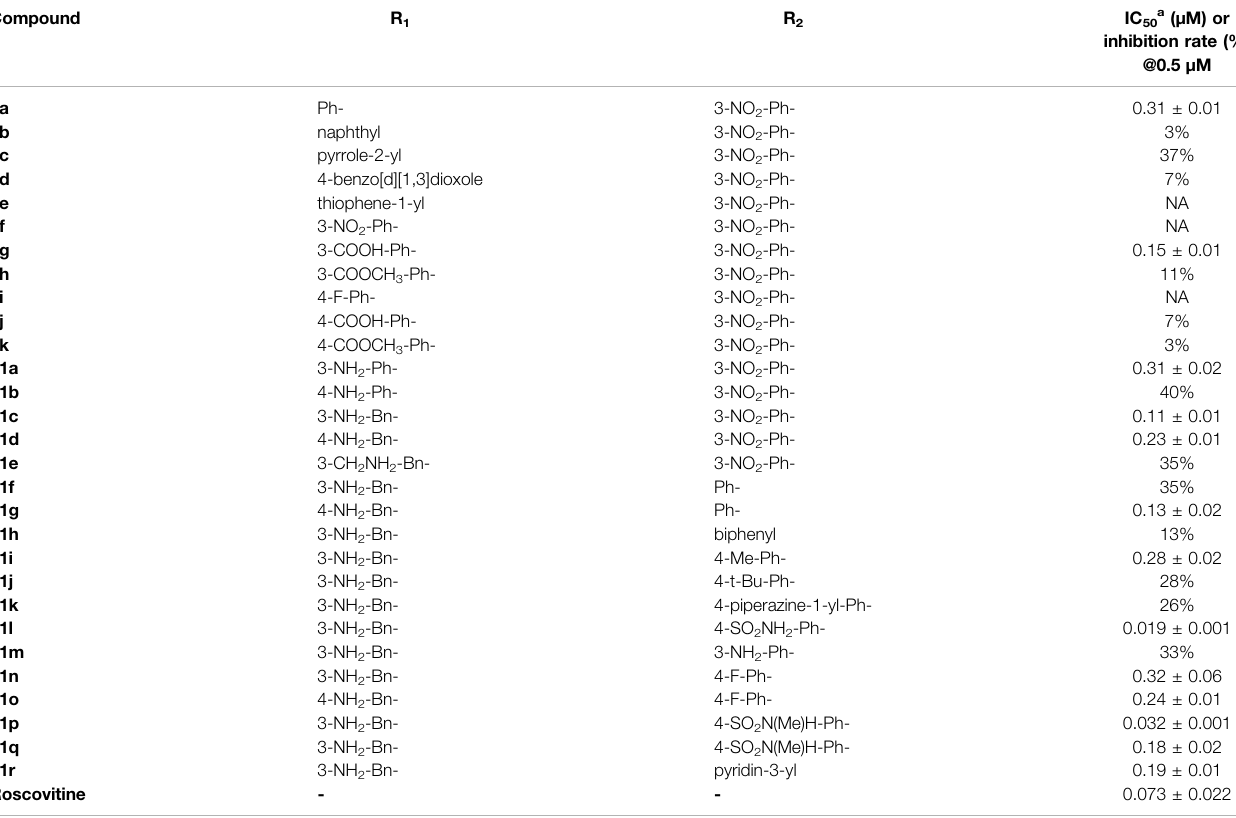
a Values are geometric means of n P 3 experiments, with a range of less than 20% of the mean value.